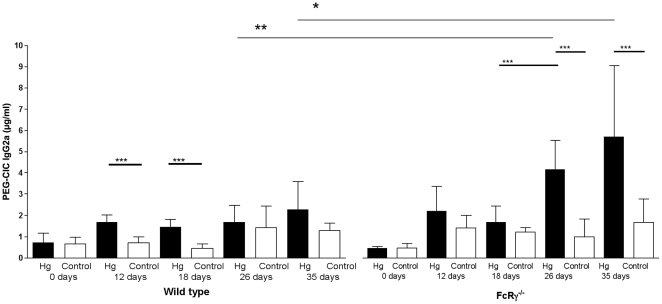
Development of circulating IgG2a immune complexes.Development of PEG-precipitated circulating IgG2a-containing immune complexes during 26–35 days of treatment of female BALB/c wild type and FcRγ−/− mice with 15 mg/L HgCl2 in the drinking water or drinking water without any addition of Hg (controls). The bars denote mean ± SD. * p<0.05, ** p<0.01 and *** p<0.001 (Mann-Whitney's test).